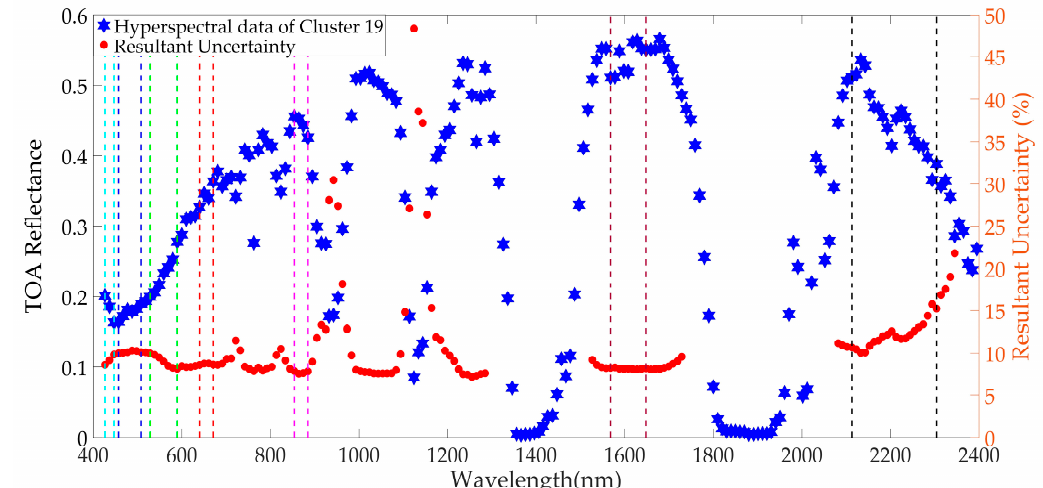
Figure A15. Estimated representative hyperspectral profile of Cluster 18 and its resultant uncertainty.